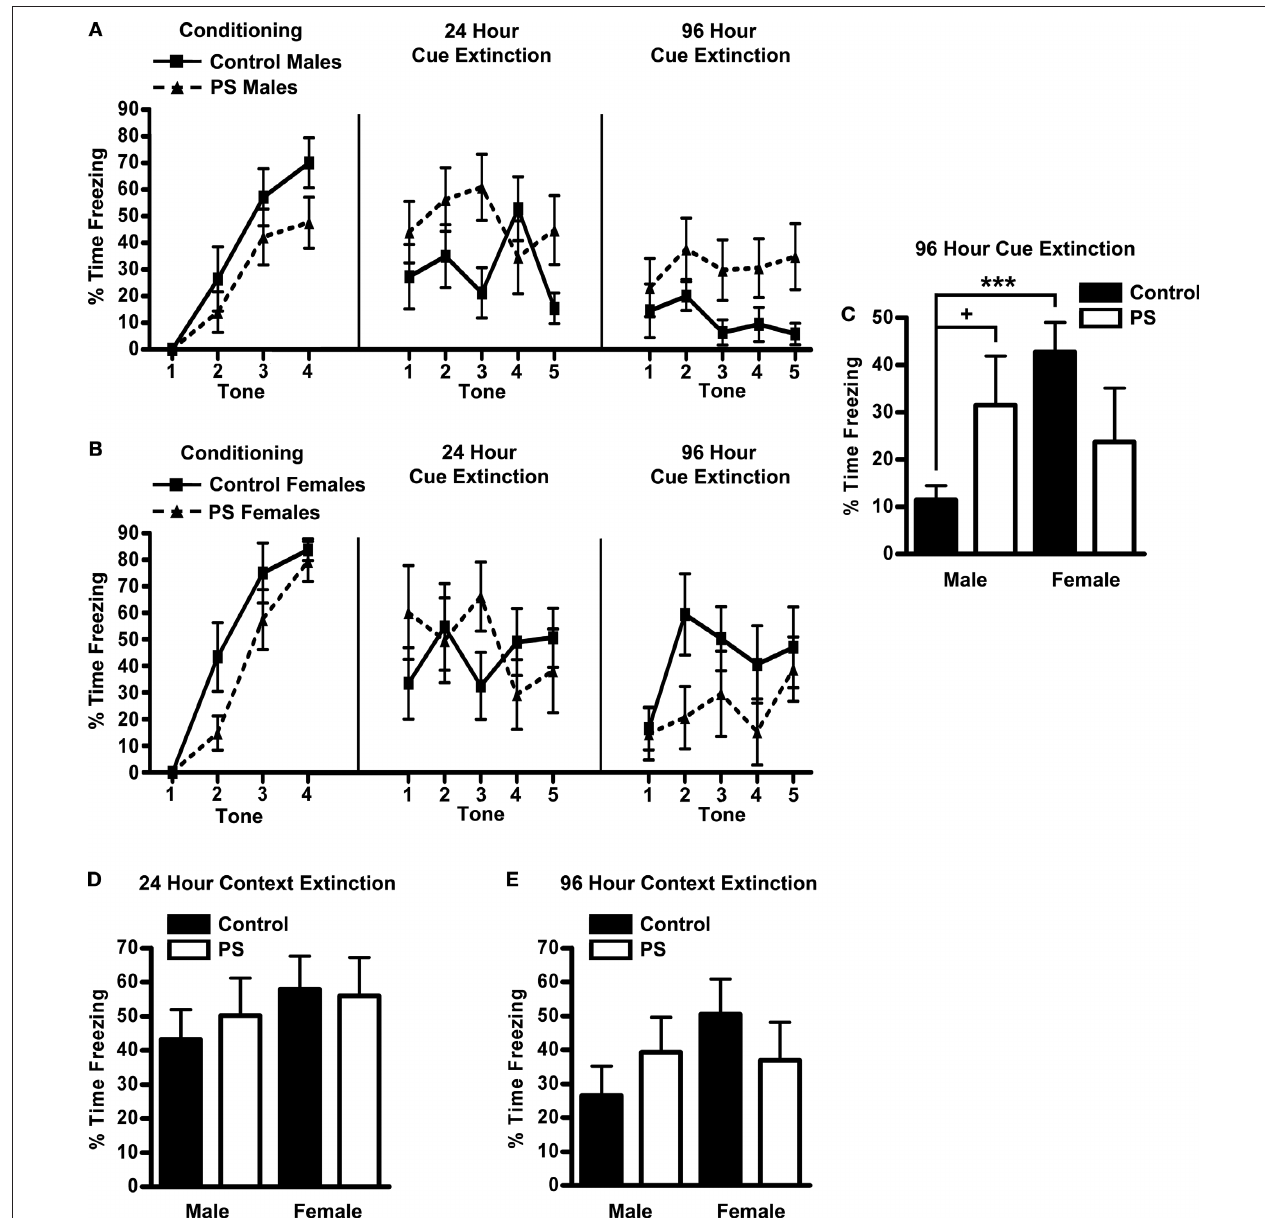
Figure 4 | Fear conditioning. Freezing in response to the tone during conditioning and cue extinction trials conducted 24 and 96 h later in male (A) and (B) female rats. Prenatal stress impaired the development of conditioned responses to the tone (treatment effect, p < 0.05), and females tended to respond more than males (sex effect, p < 0.054). Additionally, sex and treatment interacted